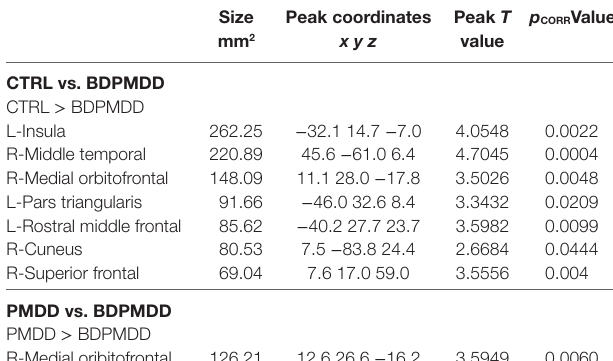
TaBle 5 | Differences in cortical thickness between